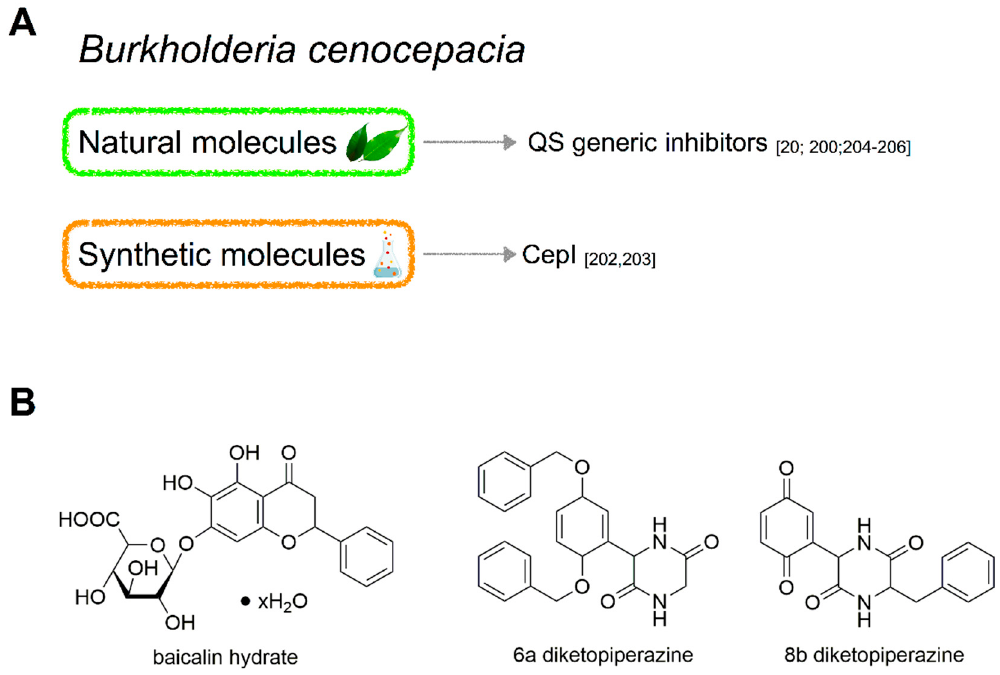
Figure 8. ( A ) Targets of natural and synthetic molecules active against B. cenocepacia quorum sensing. ( B ) Chemical structures of natural and synthetic molecules active against B. cenocepacia QS systems.